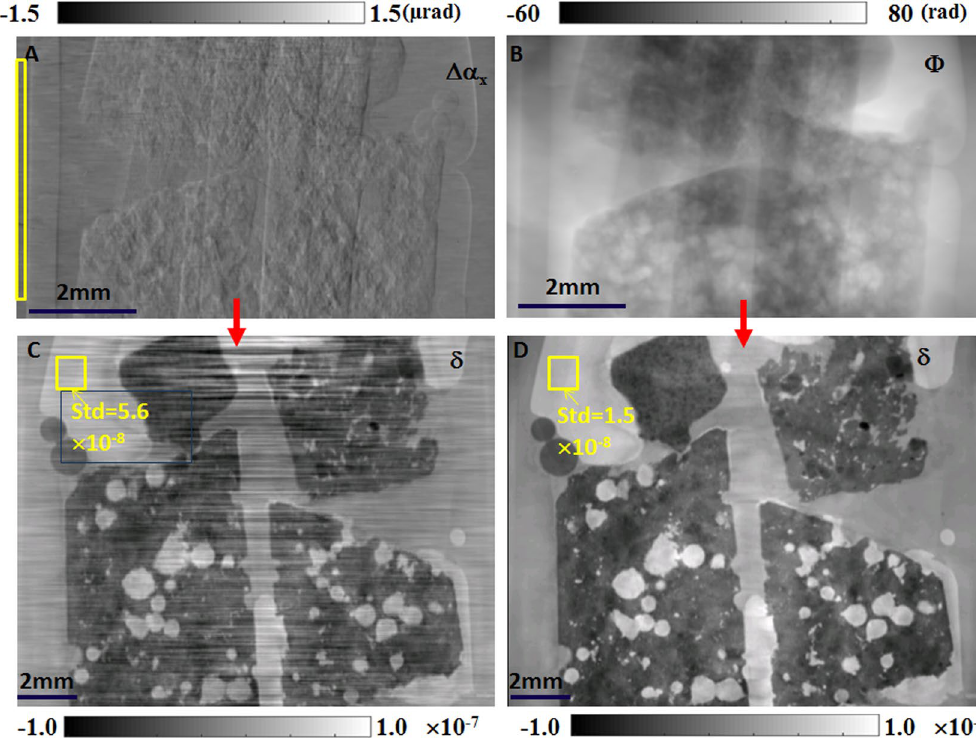
Figure 2. Retrieved results for a rock sample using fly-scan phase tomography. ( A ) Horizontal phase gradient and ( B ) reconstructed phase map of one projection. The standard deviation within the empty space in the yellow rectangular box is used to quantify the angular sensitivity of the wavefront gradient. ( C , D ) Sagittal slices of the reconstructed phase tomography using ( A ) the phase gradient and ( B ) the phase shift, respectively. The standard deviation in the paraffin wax inside the yellow square box is much higher in ( C ) (5.6 × 10 − 8 ) than in